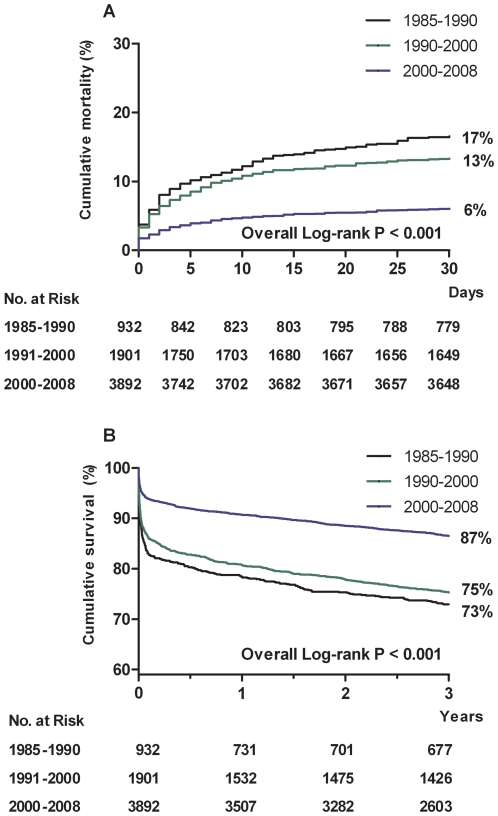
Kaplan-Meier curves for 30-day cumulative mortality (Figure 2A) or three-year cumulative survival (Figure 2B) according to calendar period of admission